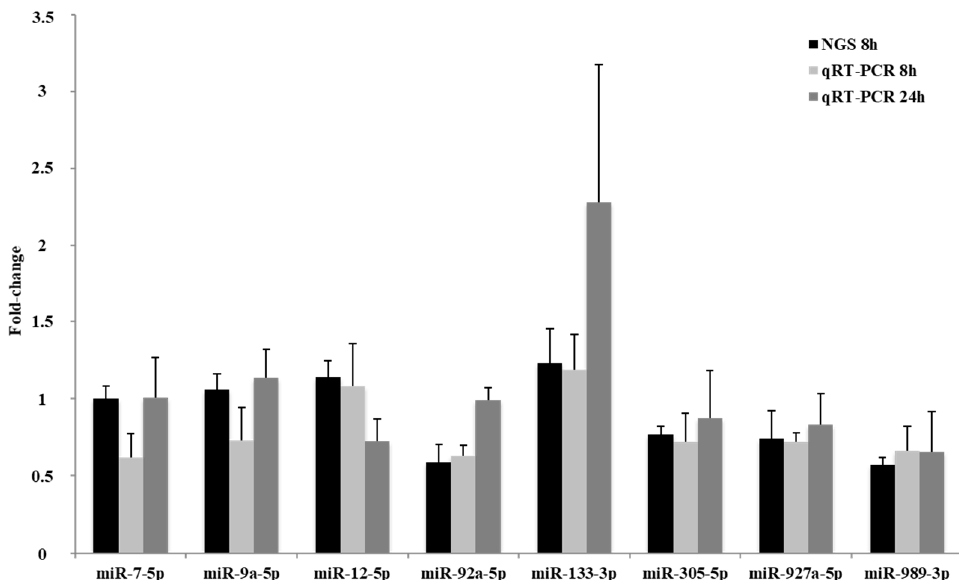
Figure 1. Next-generation sequencing (NGS) and quantitative real-time polymerase chain reaction (qRT-PCR) expression data of select miRNAs. Expression of eight miRNAs quantified in control and imidacloprid-treated L. decemlineata . Data for qRT-PCR is normalized to transcript levels (mean ± SEM, n = 3) and NGS levels represent fold-changes in normalized read counts (mean ± SEM, n = 3).